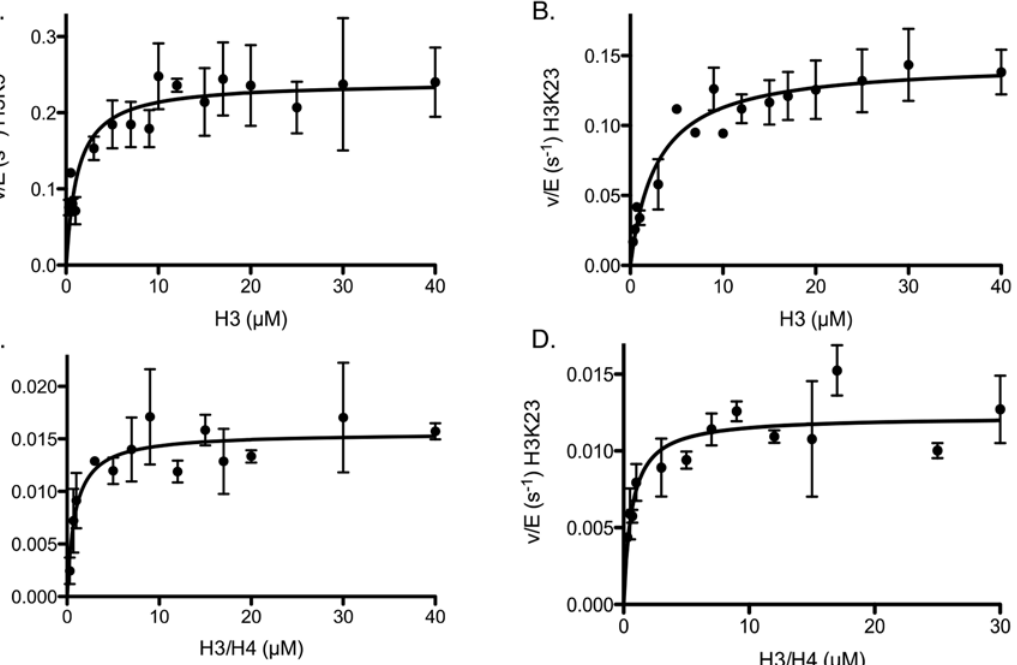
Fig 2. Determination of steady-state parameters for individual lysines of H3 and H3/H4 acetylation catalyzed by Rtt109-Vps75 when titrating histone in the presence of saturating acetyl-CoA. The detailed experimental conditions are described in the section “ Steady-state kinetic assays for Rtt109-Vps75 ” . The error bar represents the standard error in v/E. Panels (A) and (B) show the Michaelis-Menten behaviors for H3K9 and H3K23, respectively, when titrating H3. Panels (C) and (D) also show the Michaelis-Menten behaviors for K9 and K23, respectively, when titrating H3/H4. H3 is the preferred substrate for Rtt109-Vps75 acetylation. The apparent kinetic parameters are summarized in Table 1.